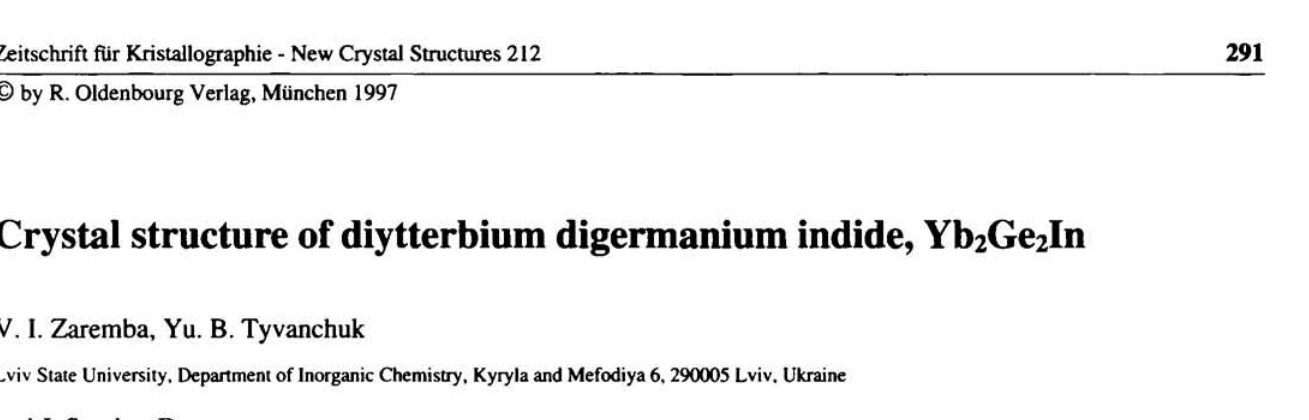
Source of material: The alloy was prepared by arc melting of pure elements and annealing at 870 Κ for 720 h.